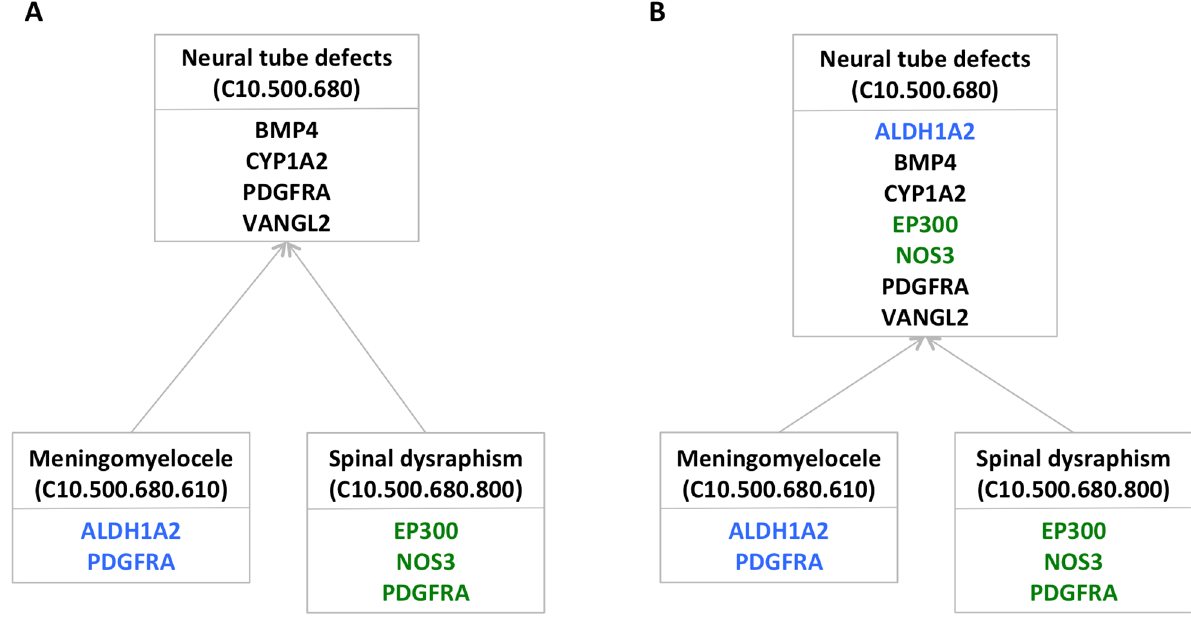
Figure 1. Pooling genes across related diseases to assess enrichment. a) Lung development genes linked directly to three related MeSH terms. The genes associated with each term are shown in a different color. b) By pooling the lung development genes from the subtree rooted at the Neural tube defects node, we obtain enough genes to identify significant enrichment at that node. Colors, the same as those in part a, indicate the disease terms with which the genes were associated before pooling.